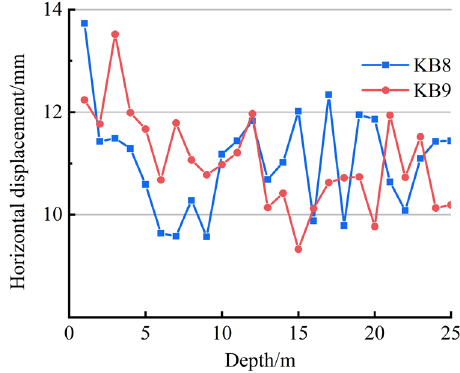
Figure 8: Horizontal displacement of external corner and internal